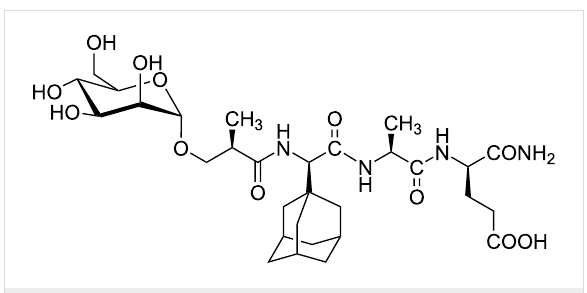
Figure 2: Immunostimulating mannosylated desmuramyl peptide